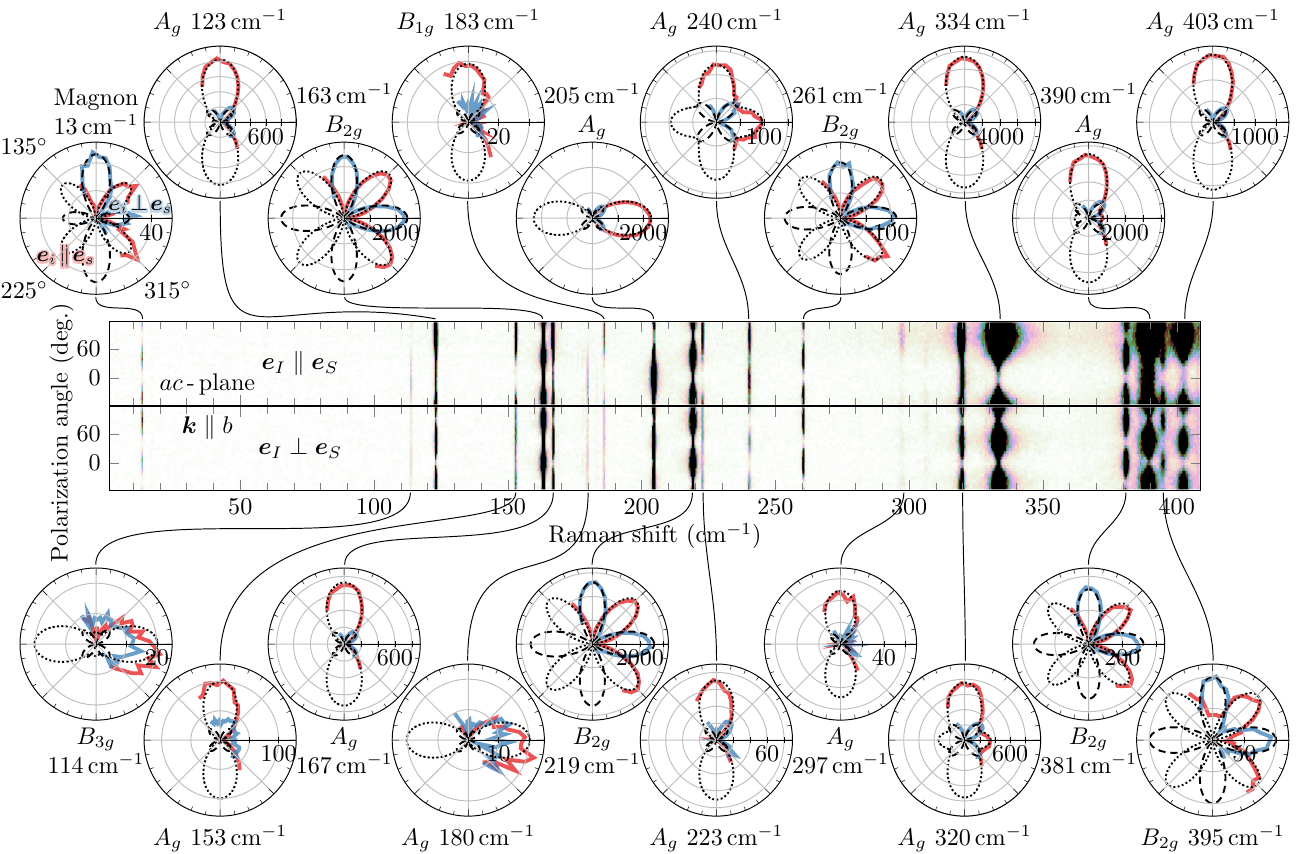
Figure 4. Raman scattering maps of the intensity, plotted as a function of Raman shift and angle between the crystallographic axis and e I , measured on the ac plane at 4.2 K, shown in the middle. Polar dependencies of the integral intensities (magnitude (counts/s/mW)) are shown above and e S ) and crossed ( e I e S ) polarization below. Red and blue solid lines correspond to parallel ( e I (cid:107) ⊥ configurations. Black dotted and dashed curves are the results of model calculations (Equation (2)) for these configurations, respectively, and are used to extract the Raman tensor elements. The symmetry and frequency of each mode are shown close to the relevant polar